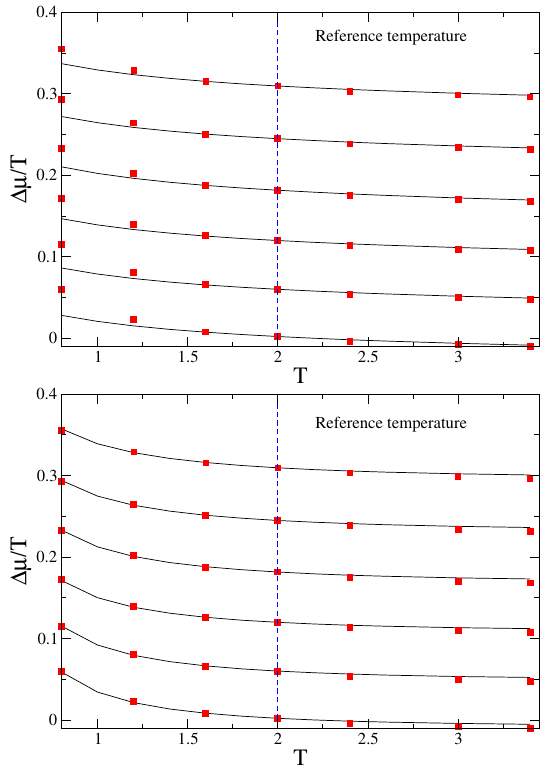
Figure 3: Reduced driving force along several liquid isomorphs, predictions based on data from = 2.0. Red squares were determined using thermodynamic integration the reference point T 0 and interface pinning [ 49, 50 ] . (a) first order approximation; (b) second-order terms added. The lowest curve corresponds to an isomorph which intersects the melting line at T = 2.0. The others are inside the supercooled region. The liquid densities at T = 2.0 are, from the bottom up, 1.065, 1.085, 1.105, 1.125, 1.145,